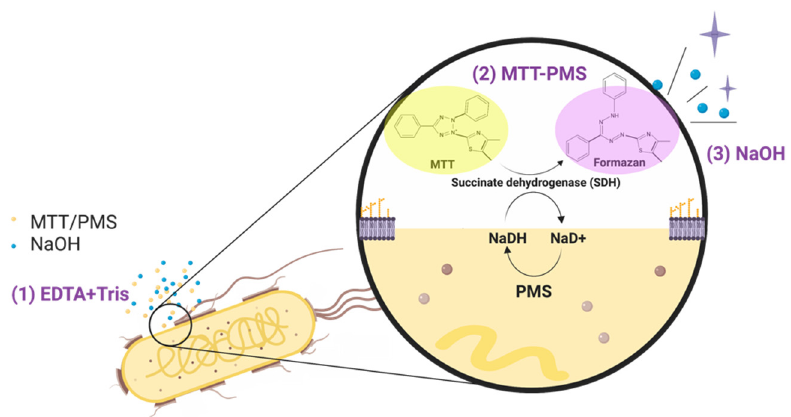
Figure 1. Mechanism of the 3-(4,5-dimethylthiazol-2-yl)-2,5-diphenyltetrazolium bromide-phenazine methosulfate (MTT-PMS) assay: ( 1 ) Tris/EDTA solution was used to penetrate bacterial cell walls and MTT/PMS was allowed to react with cellular succinate dehydrogenase; ( 2 ) MTT-PMS and NaOH were added to the solution. The lightly-colored tetrazolium salt was reduced to an intensely purple formazan form; ( 3 ) NaOH stimulated and amplified the reaction. The entire process was completed within 15 min. The figure was created using BioRender.com .